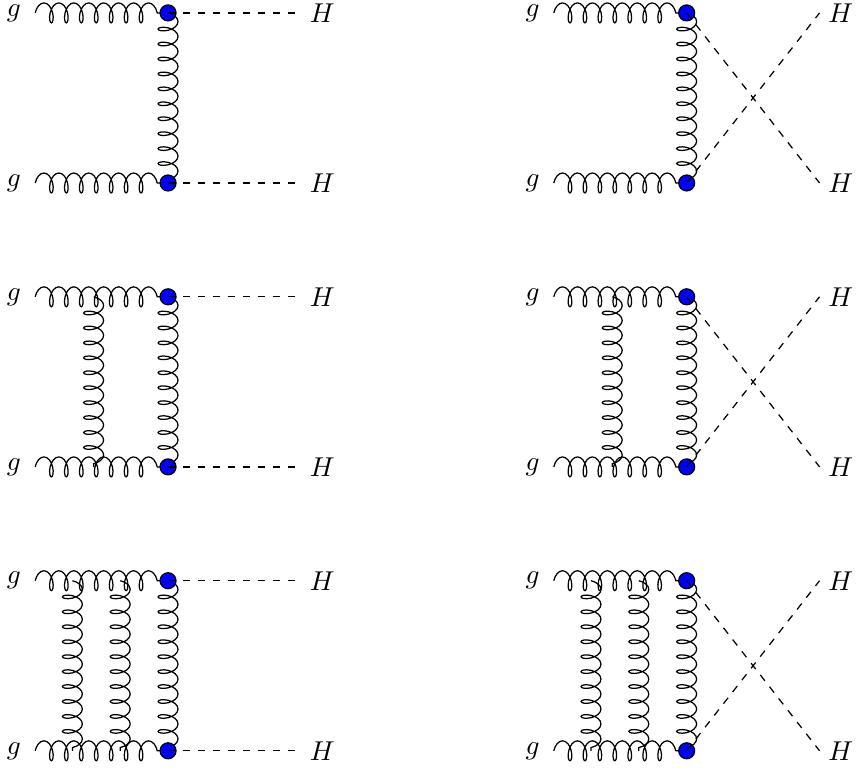
Figure 2 . Class-B: tree, one- and two-loop